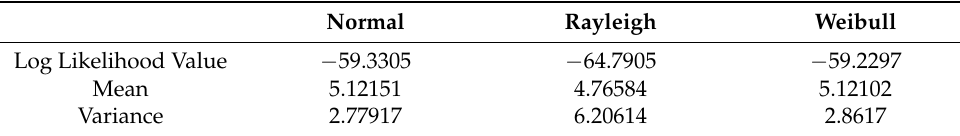
Figure 1. Past wind speed data fittings. Table 1. Past wind data fitting results for different